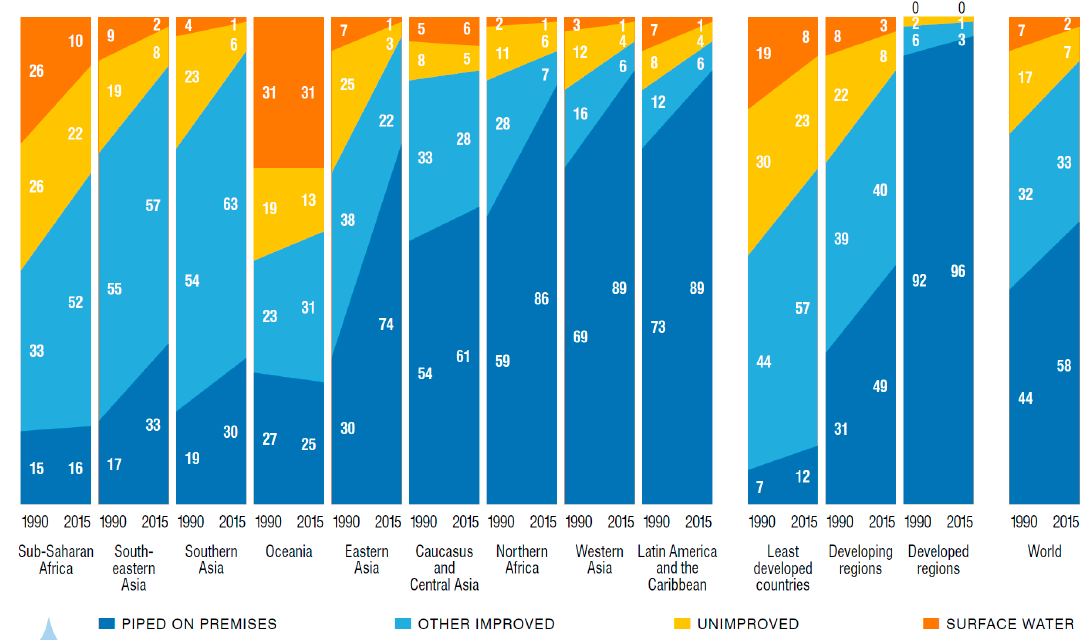
Figure 1. Drinking-water coverage trends by developing regions and the world, using the JMP improved water definition, 1990–2015. Reproduced with permission from World Health Organization and UNICEF [11].